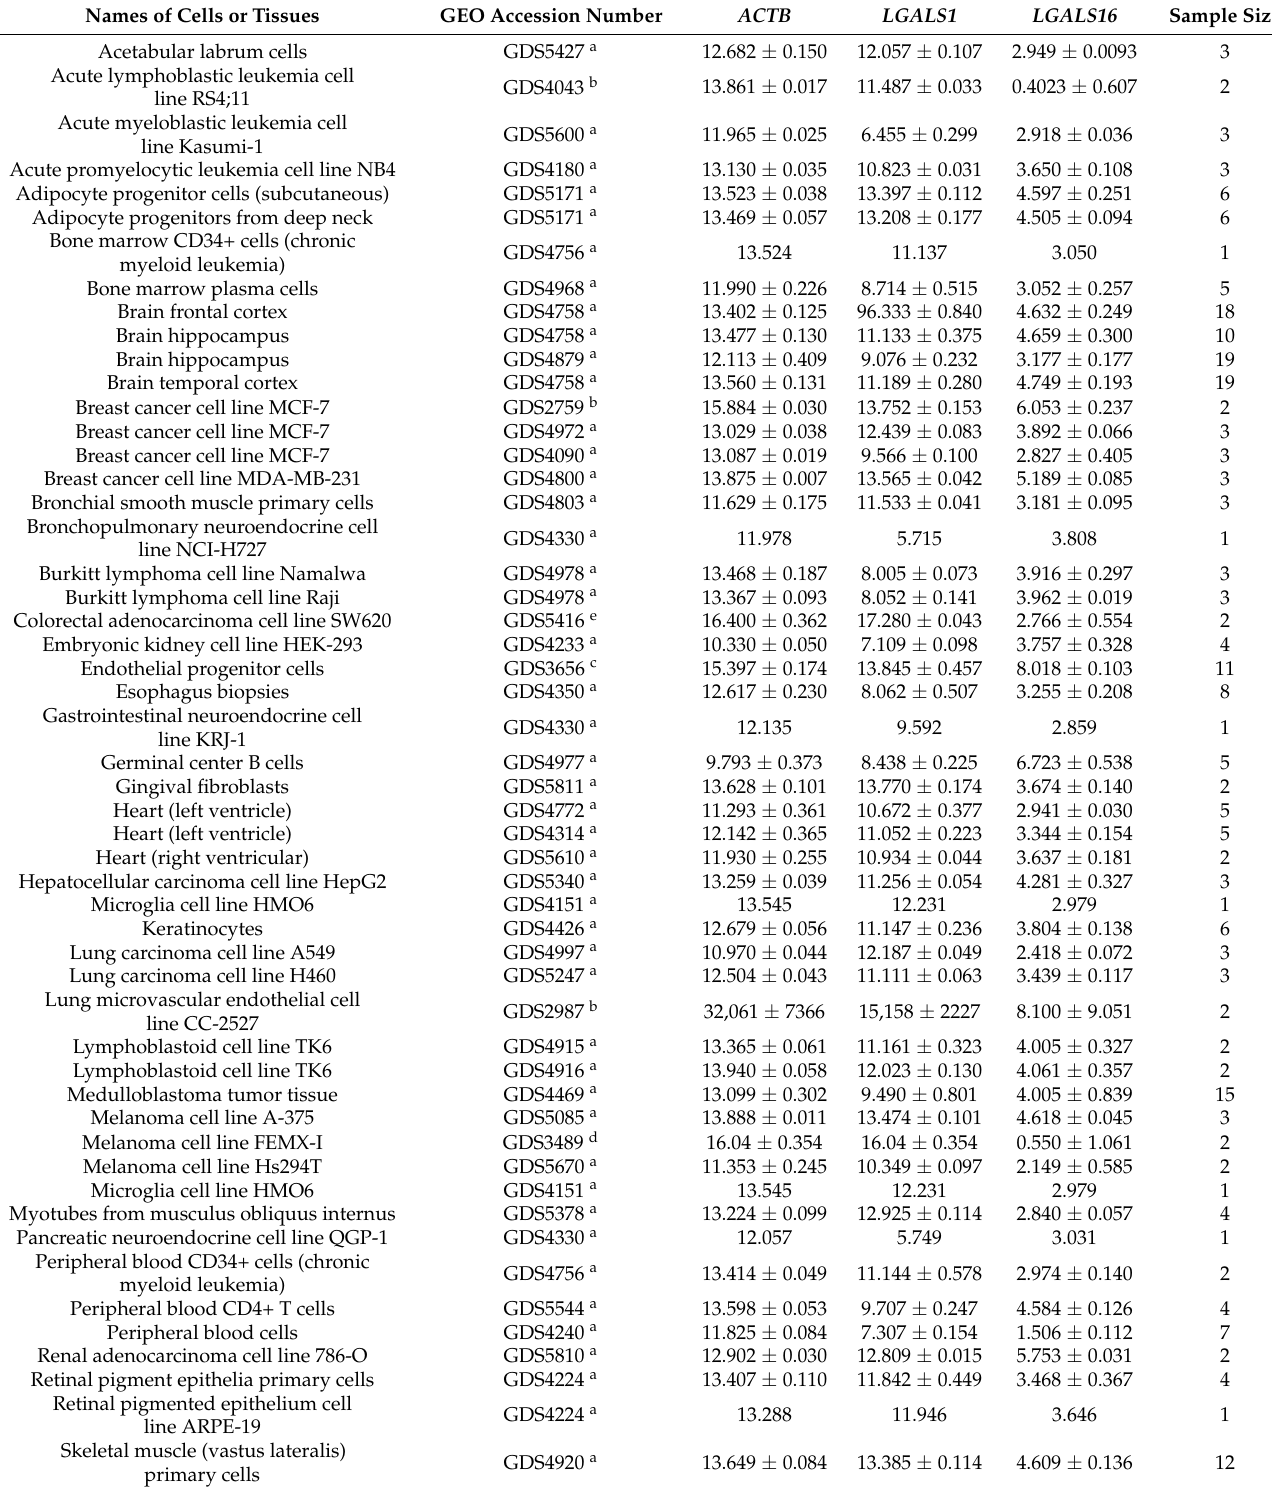
Table 1. Comparative expression of LGALS16 in human tissues and cells from the Gene Expression Omnibus database. Names of Cells or